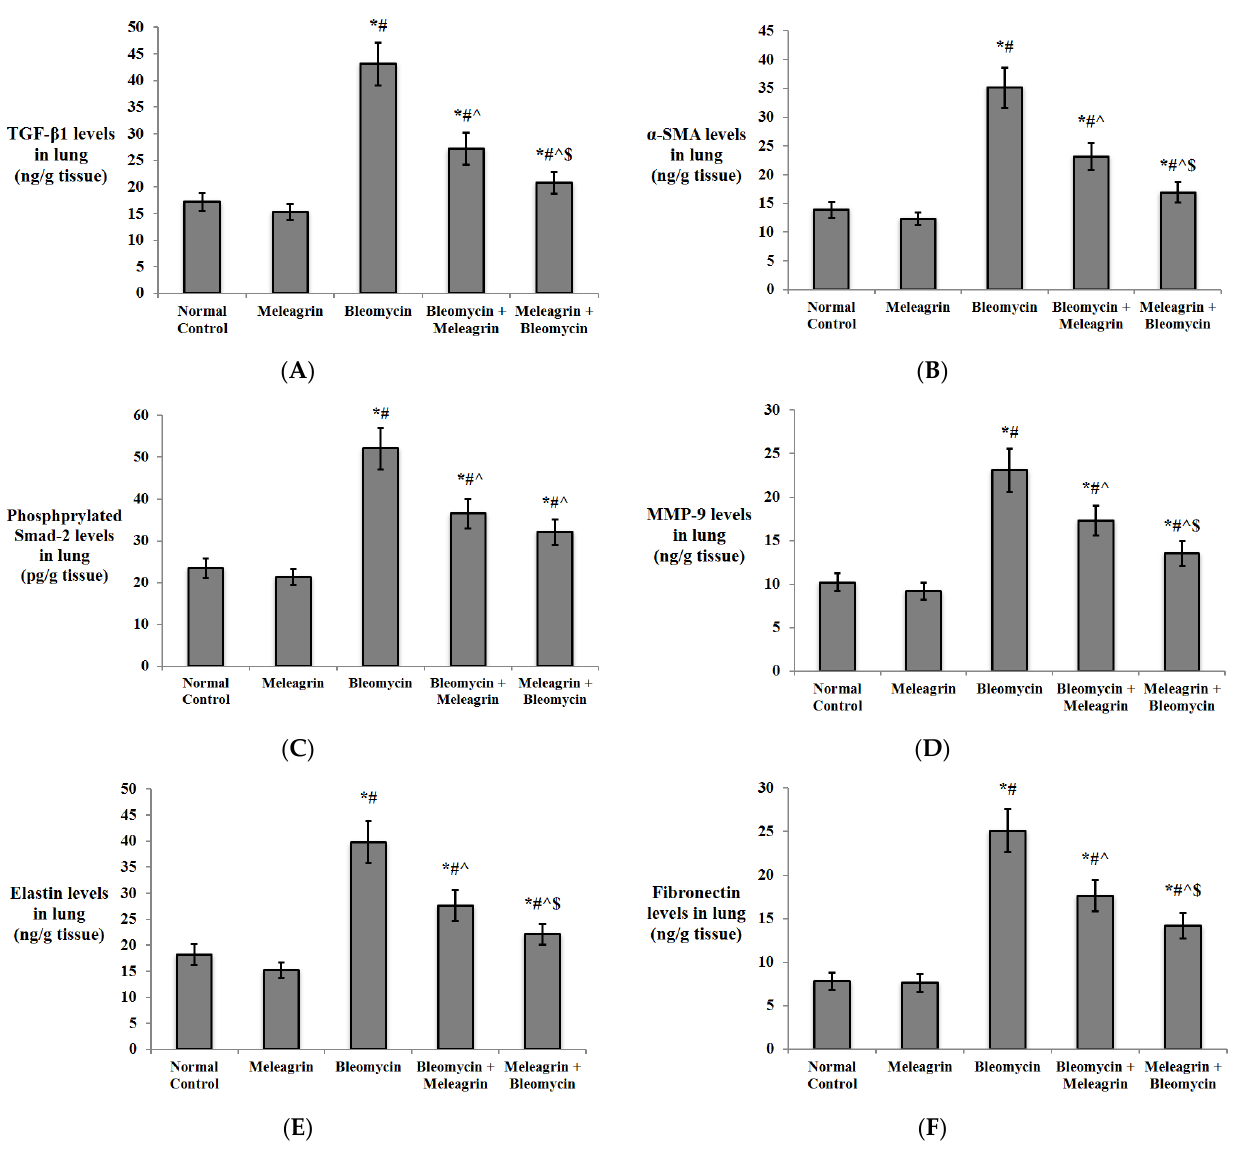
Figure 11. The effect of meleagrin on the protein levels of markers of fibrosis ( A ) TGF- β 1, ( B ) α -SMA, ( C ) phosphorylated Smad-2 and ( D ) MMP-9, and the level of extracellular matrix protein ( E ) elastin and ( F ) fibronectin in the lung tissue of the experimental mice. TGF- β 1 = transforming growth factor-beta 1; α -SMA = alpha smooth muscle actin; MMP-9 = matrix metalloproteinase-9. Data are expressed as mean ± SD and analyzed using one-way ANOVA followed by Bonferroni’s post hoc test ( n = 8). * significantly different vs. the normal control group; # significantly different vs. the meleagrin group; ˆ significantly different vs. the bleomycin group; $ significantly different vs. the bleomycin + meleagrin group. Differences were considered significant at p <